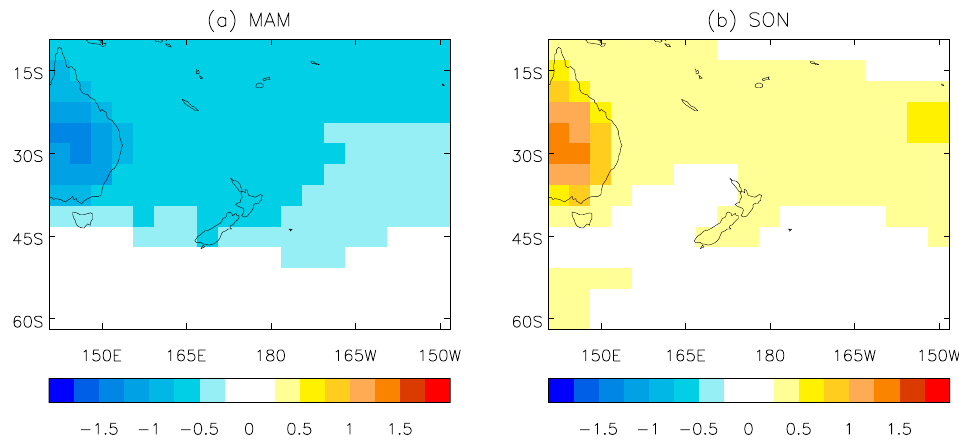
Fig. 12. The ensemble mean change in surface air temperature ( ◦ C) between the PMIP2 Mid-Holocene and the control run for (a) MAM and (b) SON. Only statistically significant changes ( p ≤ 0.05) are shaded. Refer to Table 1 for more details on each model.